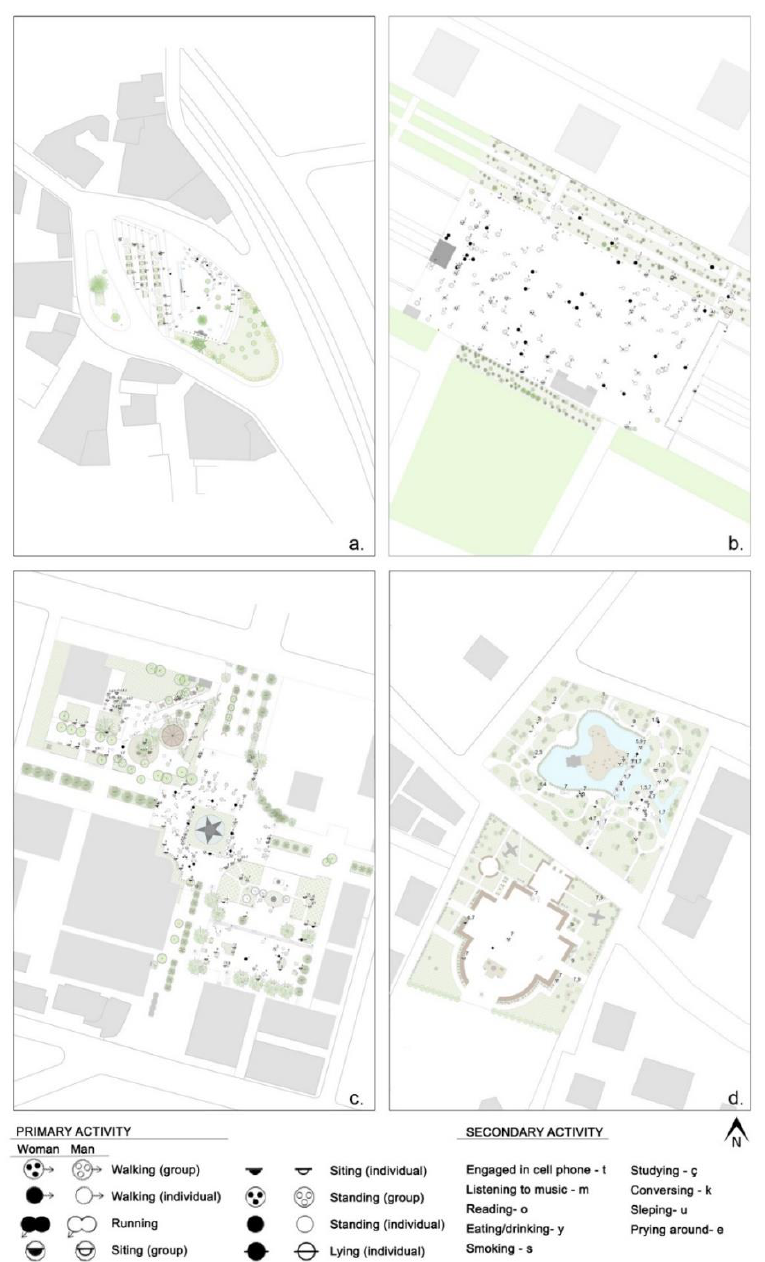
Figure 6 Behavioral mapping of the four squares (a. Küçükçekmece, b. Beylikdüzü, c. Avcılar and d.Büyükçekmece squares) during a typical observation